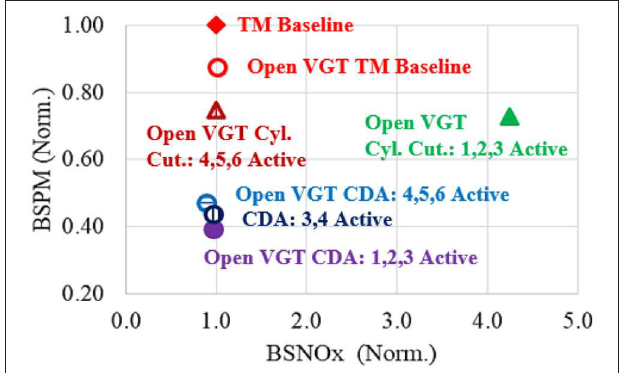
FIGURE 14 | BSNOx and BSPM normalized to the emissions of TM Baseline